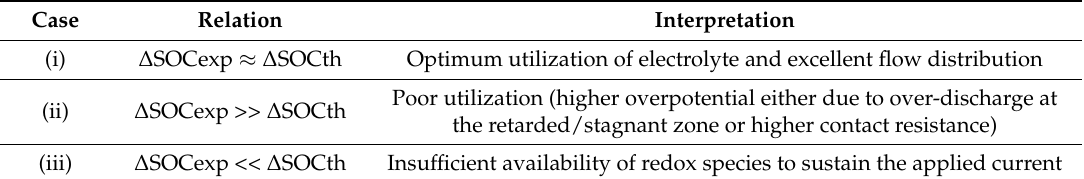
Table 1. Different performance characteristics described by the SOC changes ( ∆ SOC th and ∆ SOC exp ).